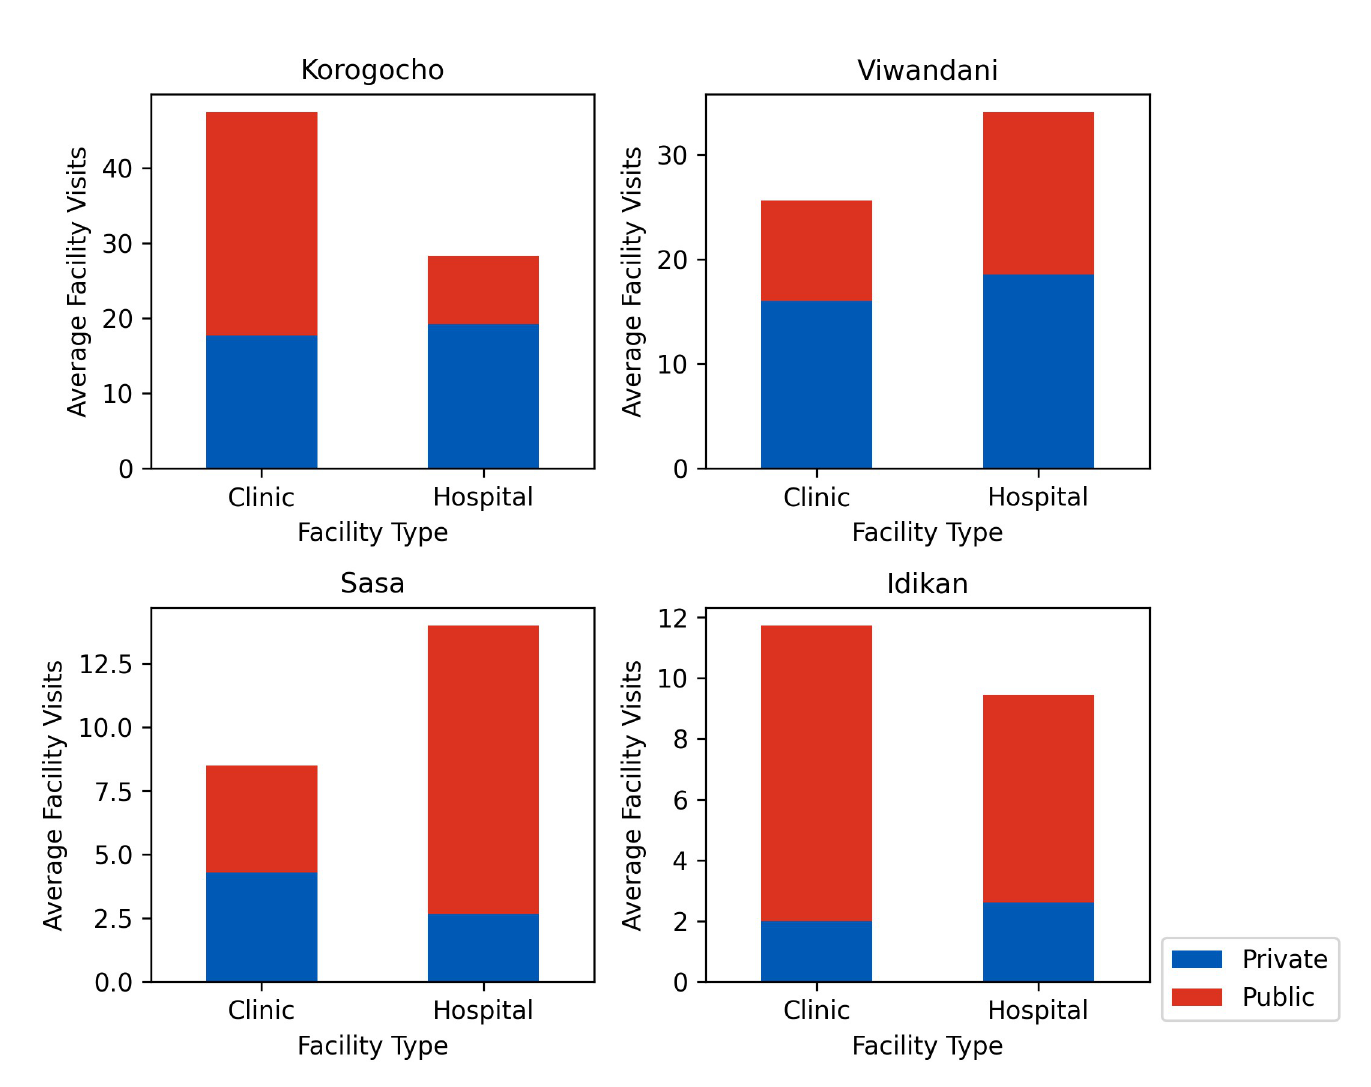
Fig 3. Grouped bar chart showing average number of HCP visits by HCP type and funding